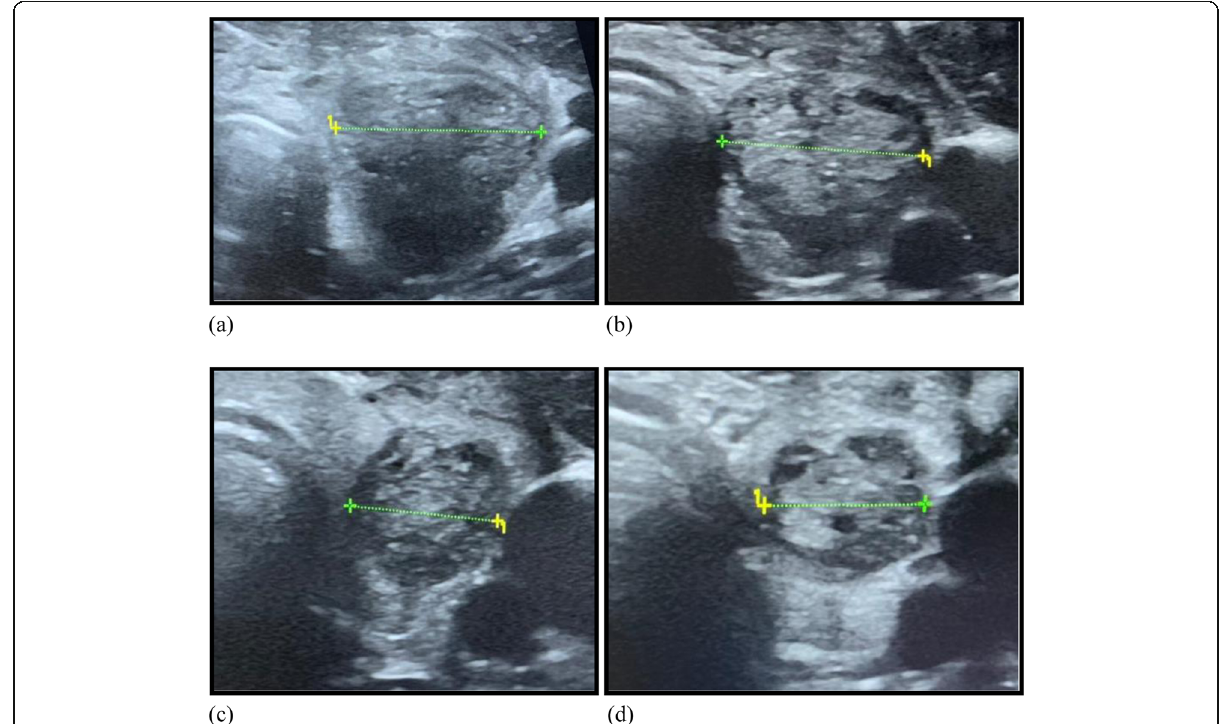
Fig. 11 A 36-year-old woman presented with solitary benign thyroid nodule. a Transverse US imaging performed before RF ablation shows a left solid nodule. b Transverse US image obtained after 1-month follow-up shows decreasing in the size of the nodule. c Volume reduction of the treated nodules on 3-month follow-up. d Marked volume reduction of the left nodule is noted on US image obtained 6 months after RF